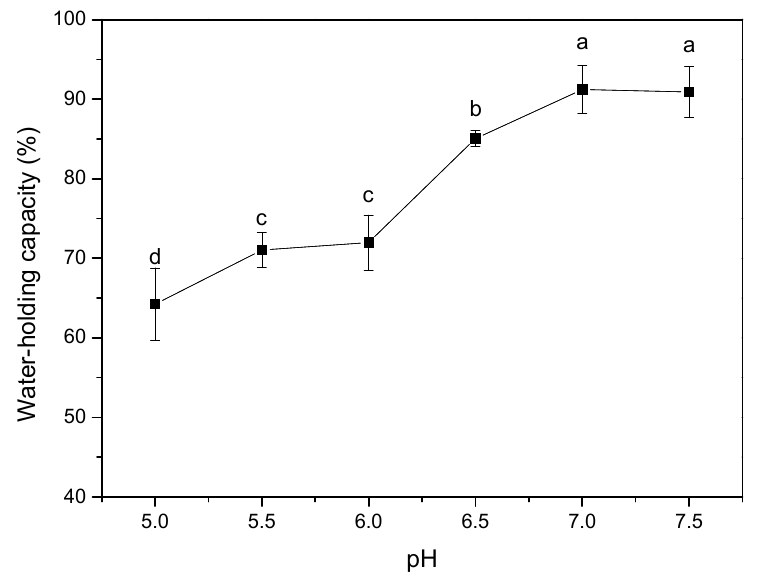
Figure 6. Water-holding capacity of CFG-SPI DN hydrogels at pH 5.0–7.5. Different letters (a–d) indicate statistically significant differences between different pH values ( p < 0.05).